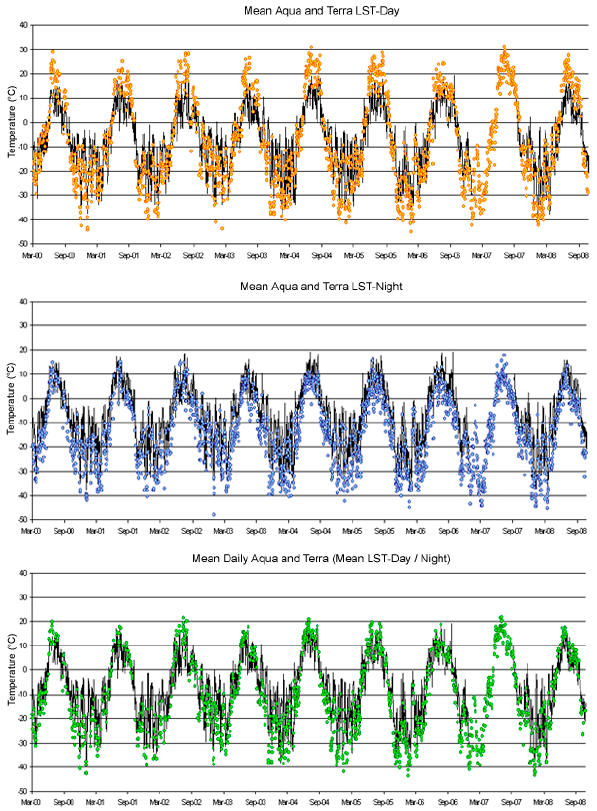
Fig. 4. Comparison between the mean LST (a) combined Terra/Aqua Day acquisitions (orange dots), (b) combined Terra/Aqua Nightacquisitions (blue dots), and (c) combined Terra/Aqua Day/Night acquisitions (green dots), with mean daily Tair (black line) forKuujjuaq2pixel at Kuujjuaq site.